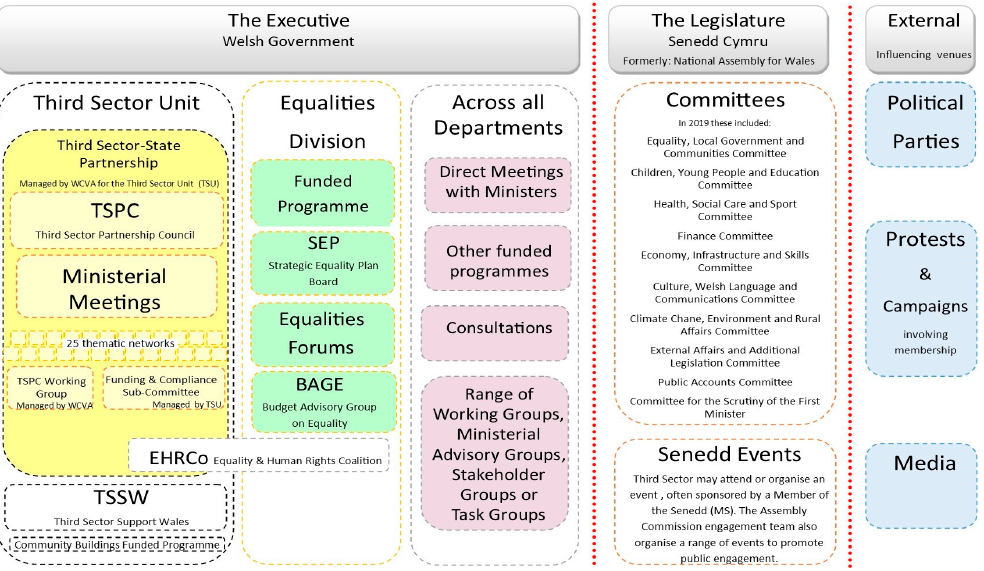
Figure 1. Policy-influencing venues in devolved governance accessed by equalities nonprofit sector organizations.